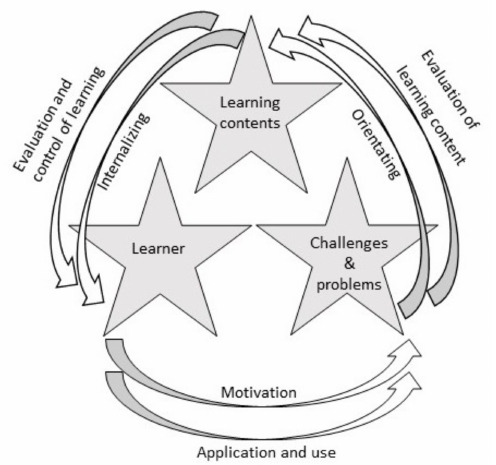
Figure 2. The meaningful learning process. The figure is inspired by Autio [21] and Engeström [22] and is based on Davydov’s concept of developmental teaching [23]. In this intervention, challenges and problems refers to: how to improve the nutrition knowledge among the athletes, learning content to: nutrition knowledge, and learner to: the endurance